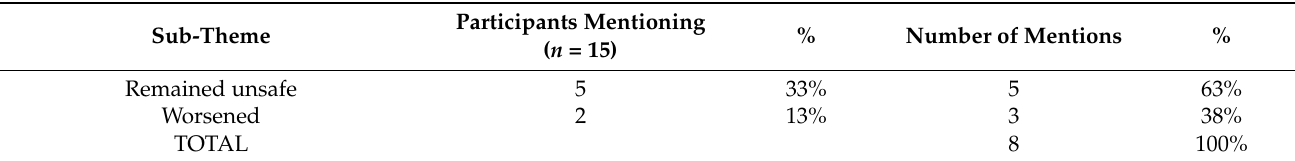
Table 8. Water quality during the water